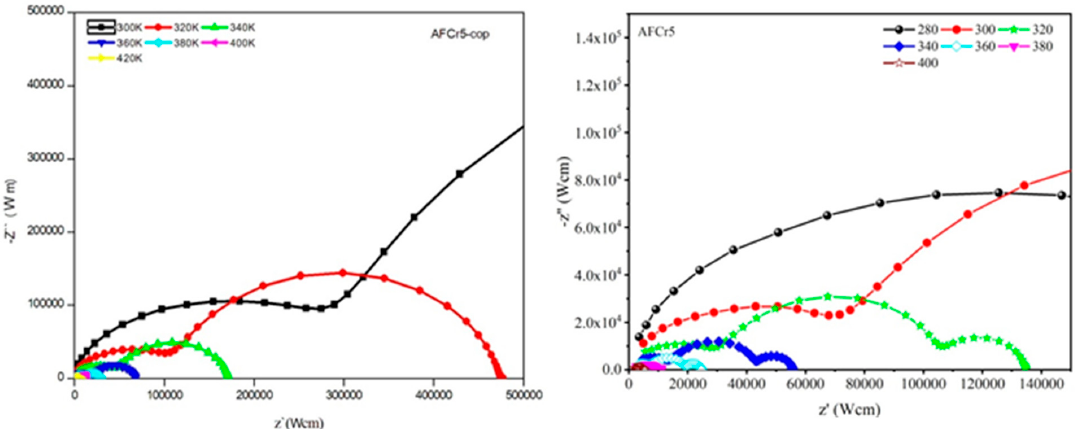
Figure 8. Nyquist plots evolution with temperature for AFCr5-s and AFCr5-cop.